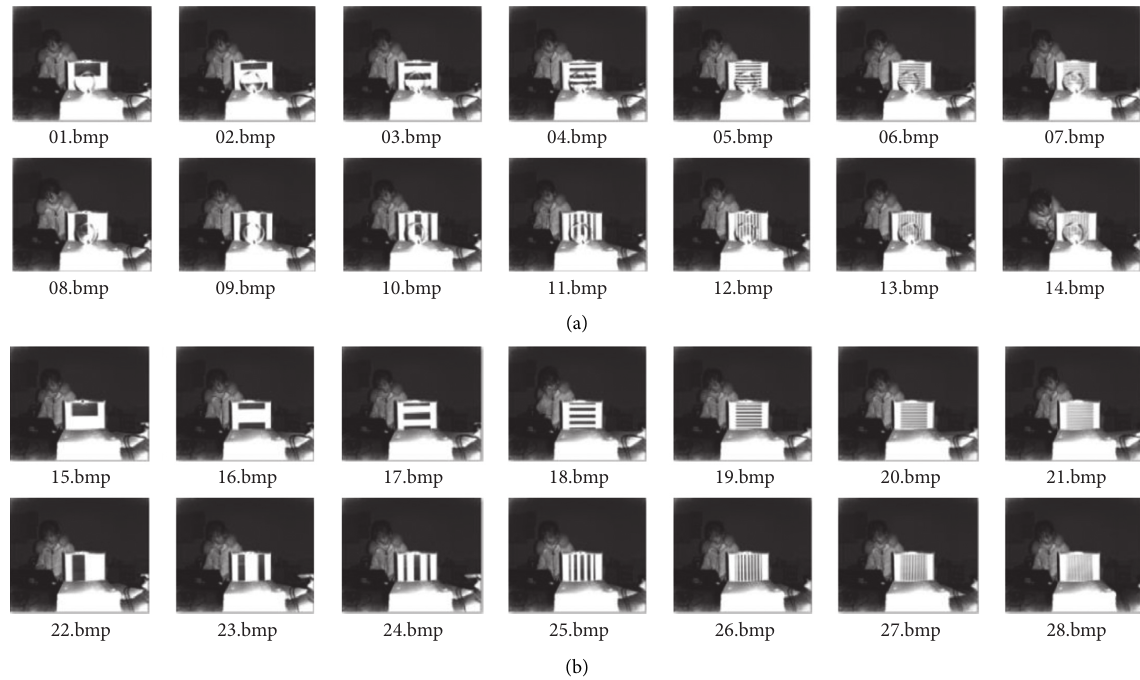
Figure 12: A set of Gray code original images. (a) A set of Gray code images with transparent objects. (b) A set of Gray code images without transparent objects.